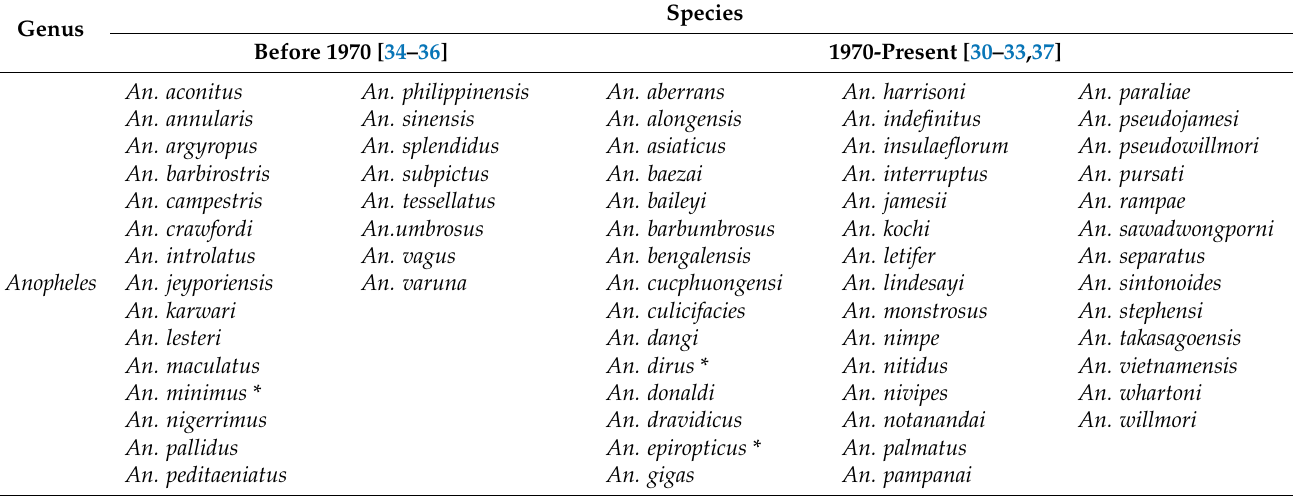
Table 1. Checklist of Anopheles , Aedes , and Culex species reported in Vietnam. Genus